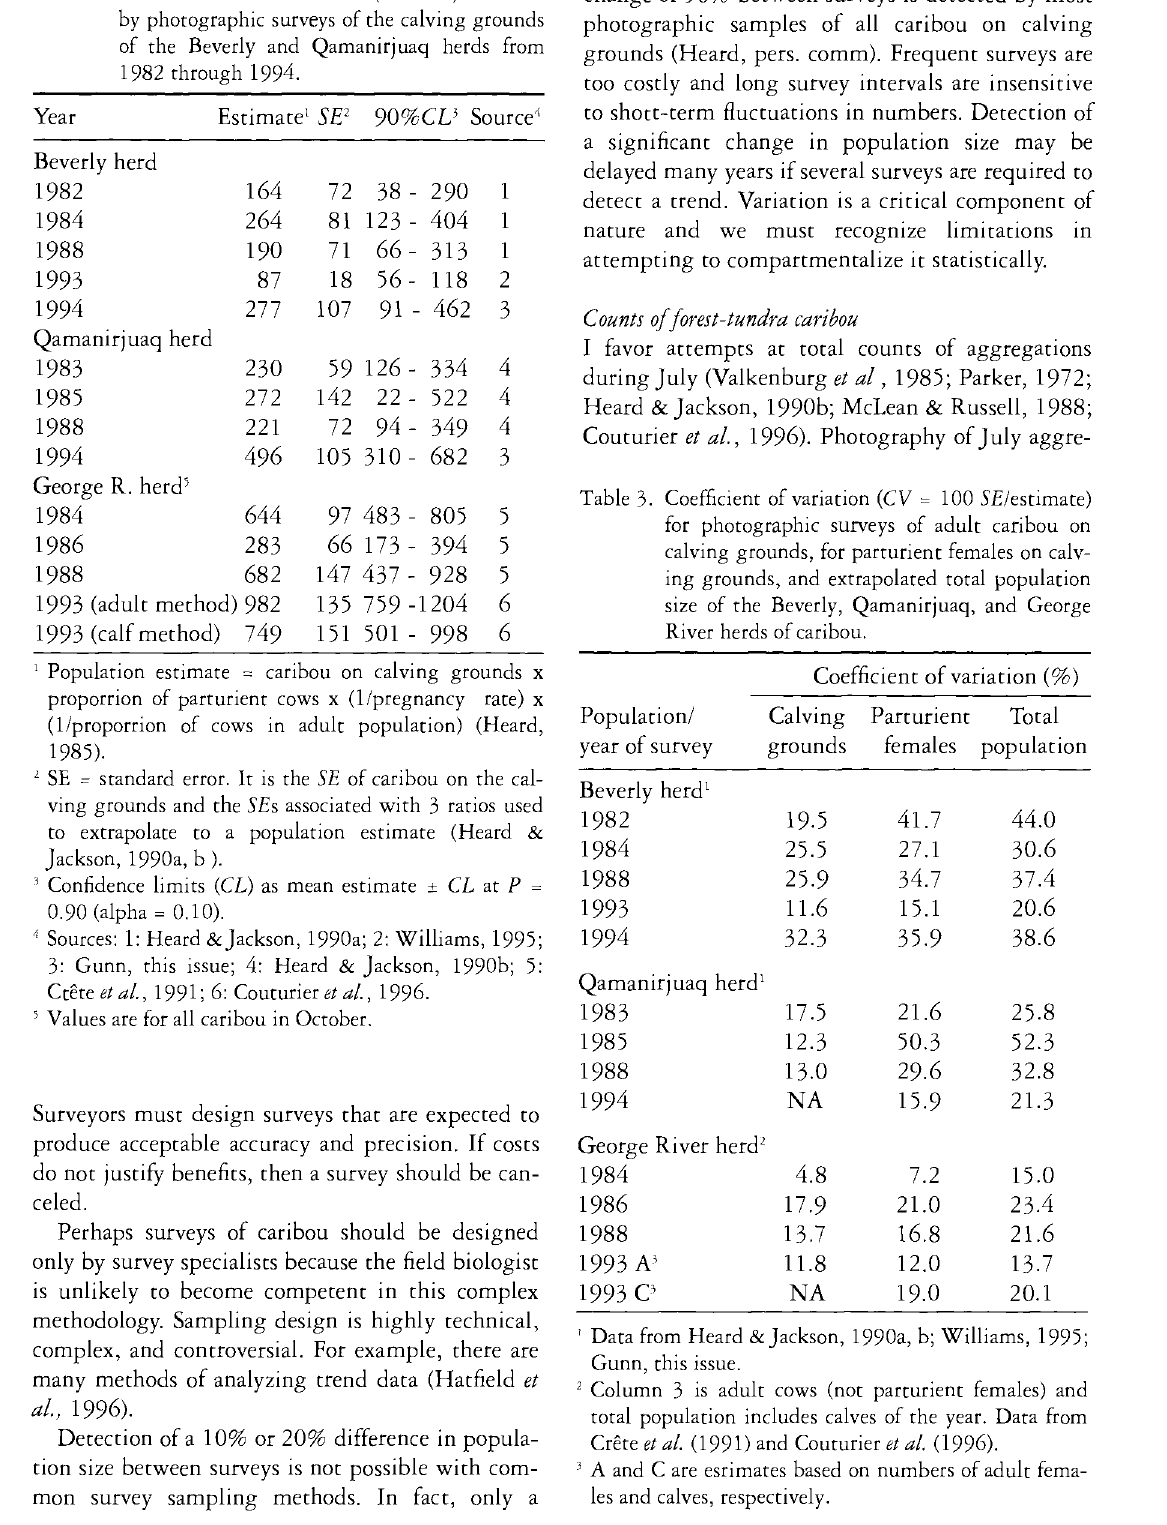
Table 2. Precision of herd estimates (X 1000) obtained by photographic surveys of the calving grounds of the Beverly and Qamanirjuaq herds from 1982 through 1994.